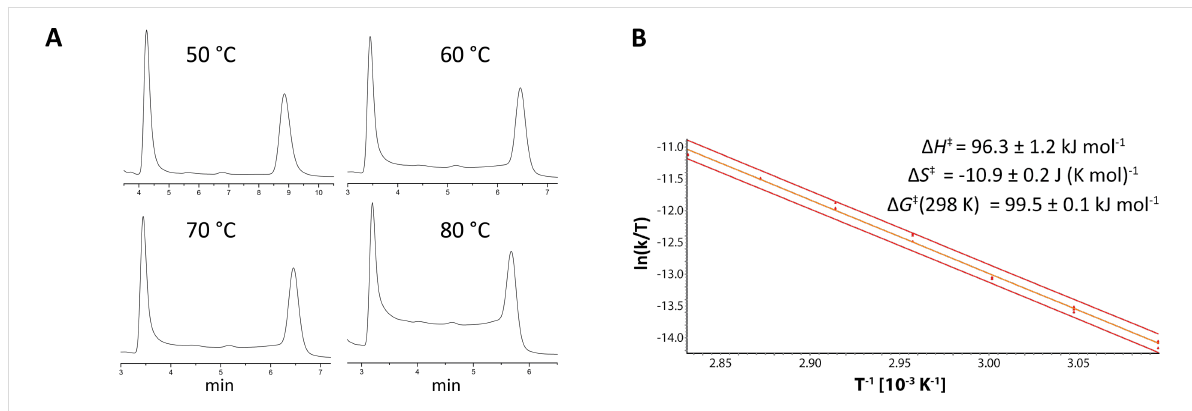
Figure 4: Enantioselective DHPLC investigation of tetrahydrobiisoindole “NU-BIPHEP(O)” 3 . A) Elution profiles at various temperatures with increas- ing plateau formation. B) Eyring plot analysis for the determination of the activation parameters Δ H ‡ and Δ S ‡ .